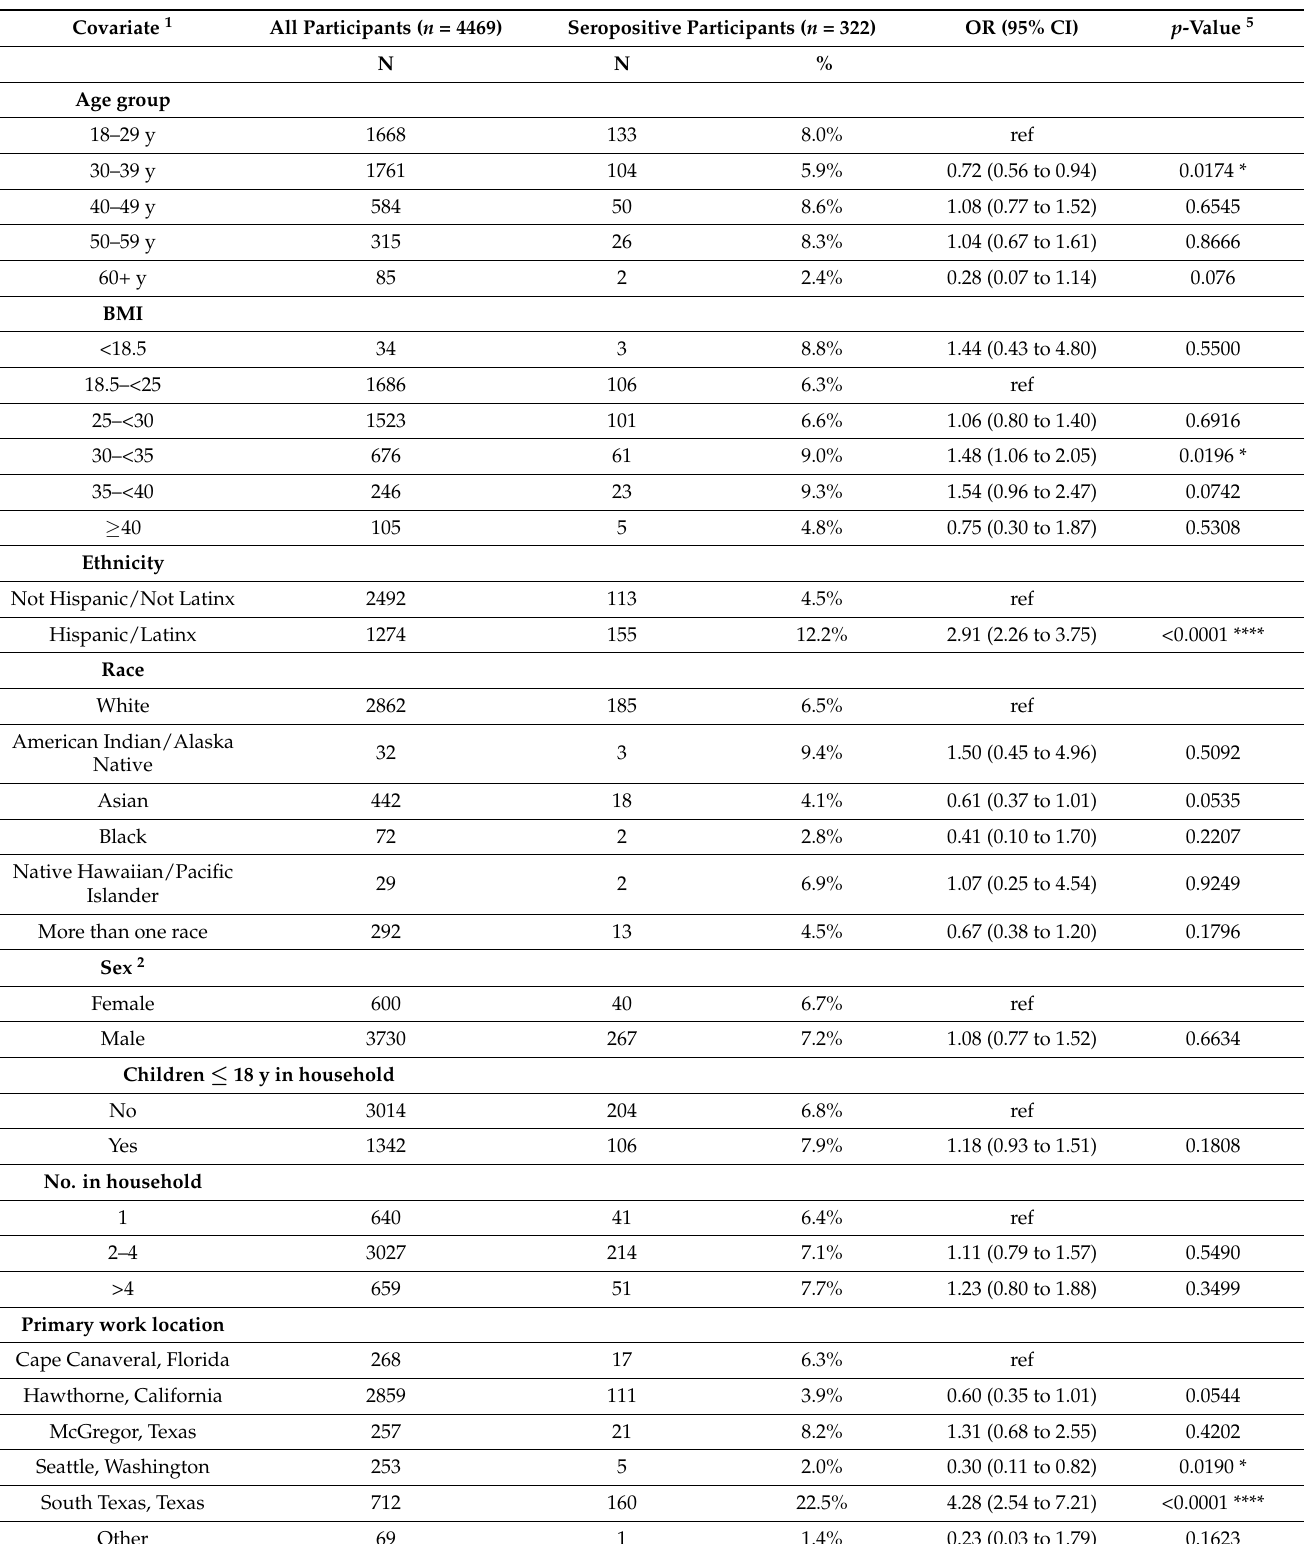
Table 1. Characteristics, serostatus, and unadjusted odds ratios of study